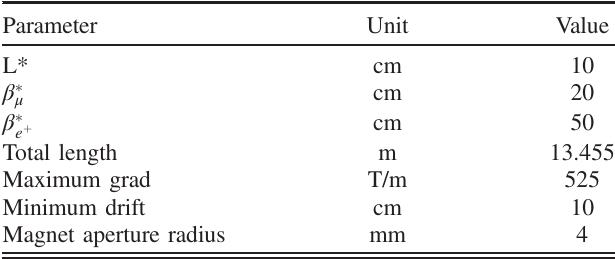
TABLE II. Transport line parameter table.